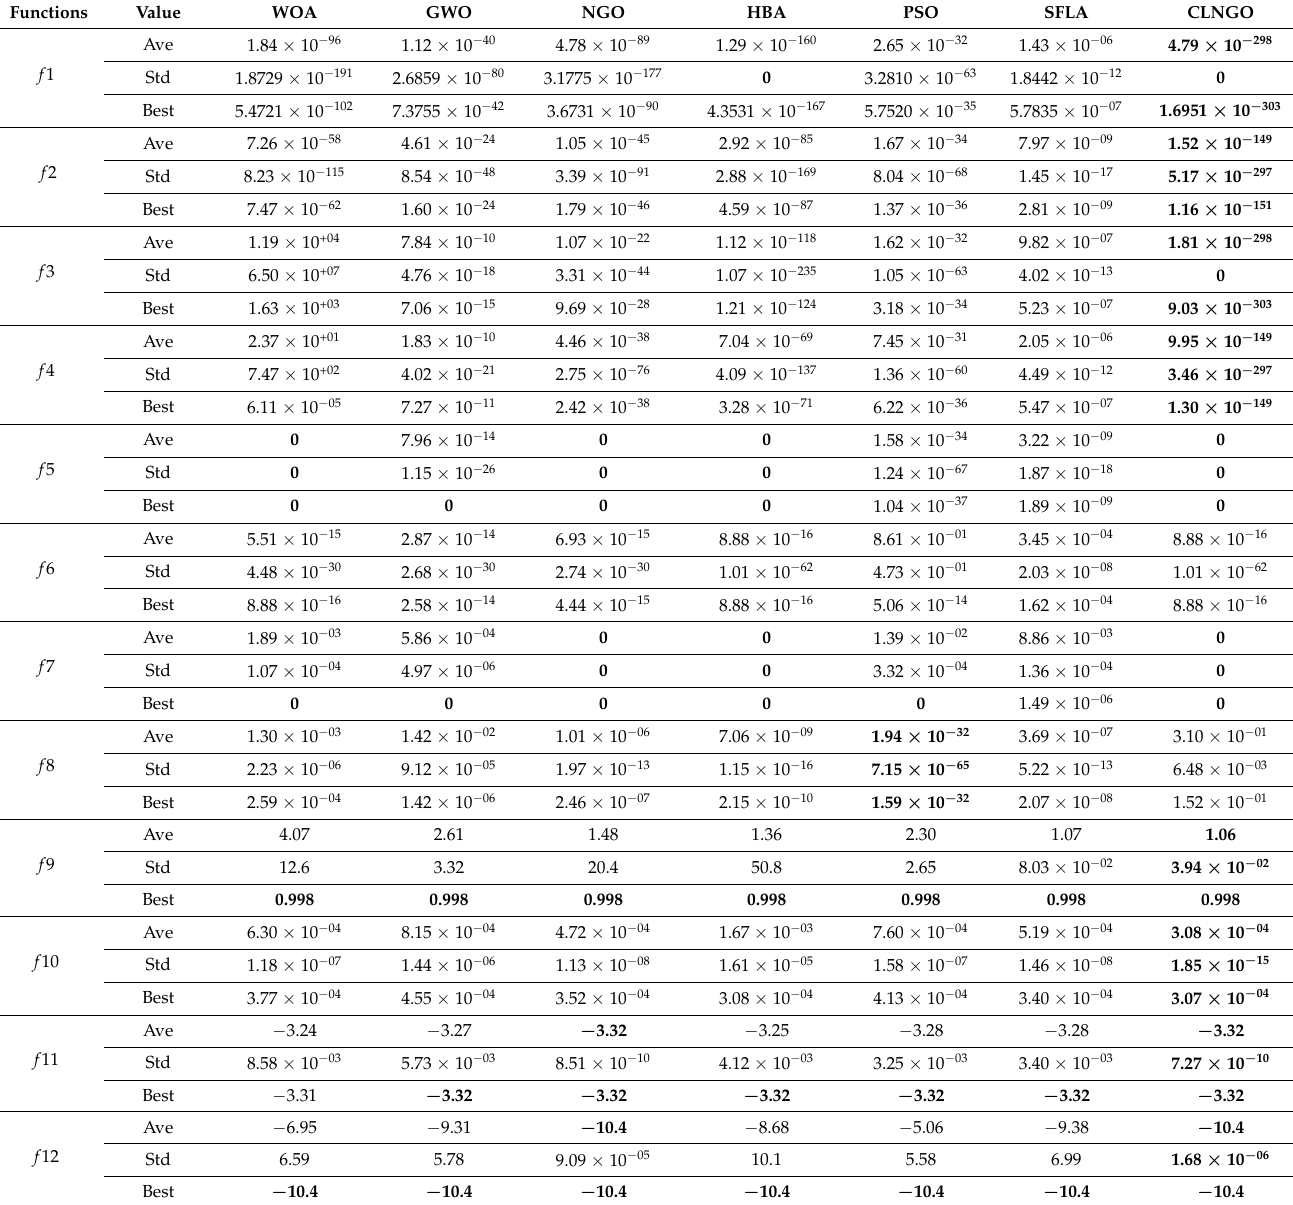
Table A1. Test Results of the Benchmark